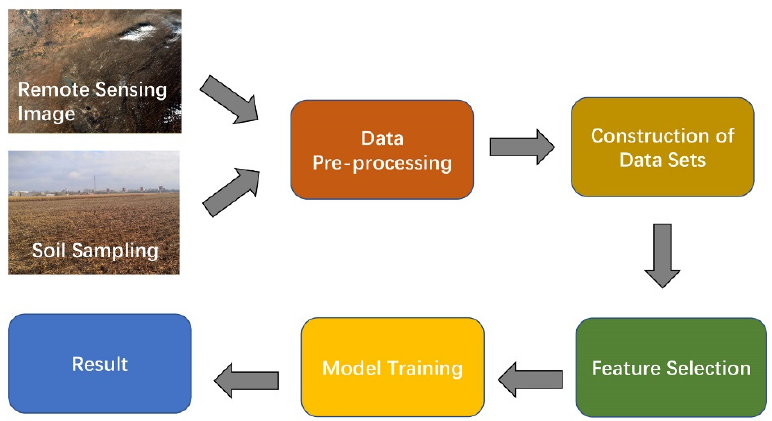
Figure 3. Flow chart of the experimental model.